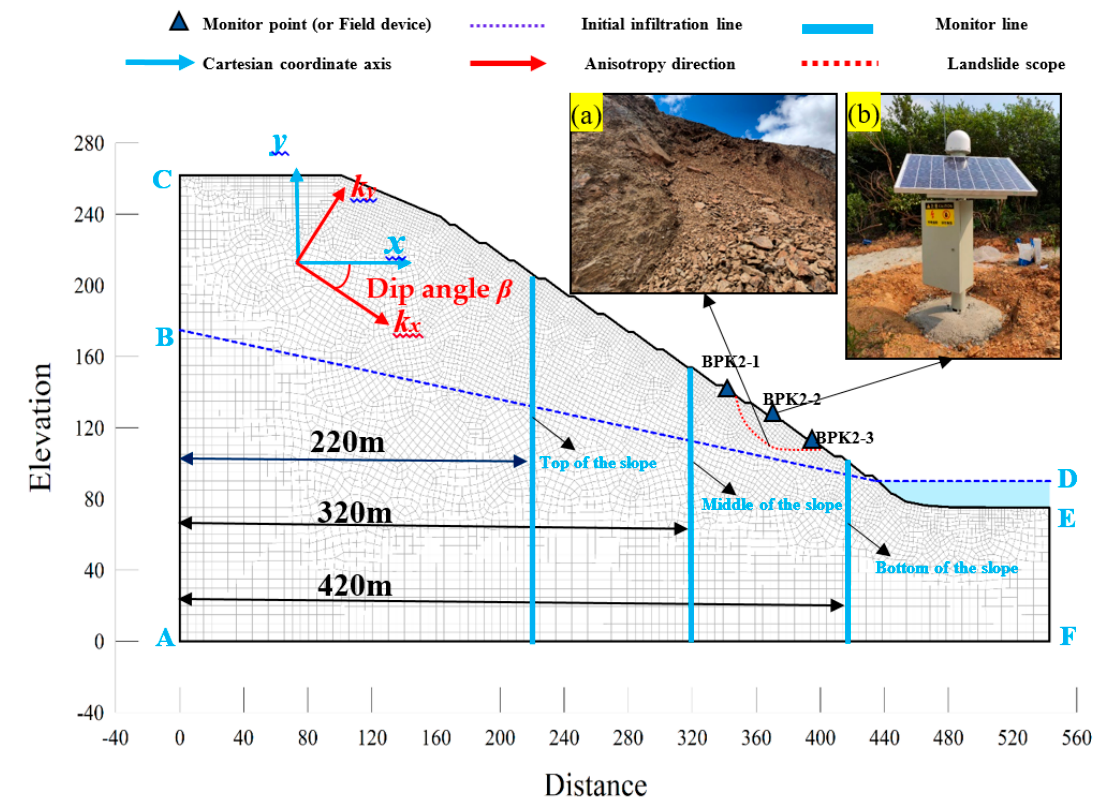
Figure 3. Grid model: ( a ) Rock landslides of rock slopes; ( b ) displacement monitoring station (BPK2-1, BPK2-2, and BPK2-3). Water 2020 , 12 , 3056